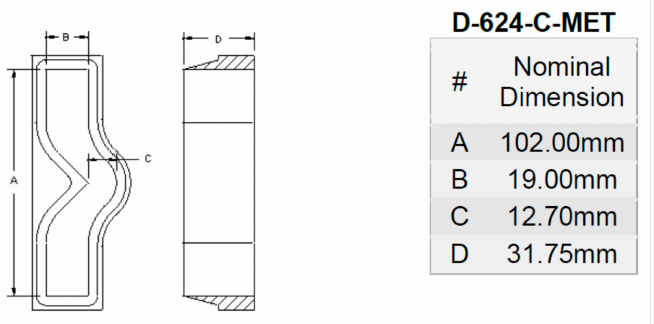
Figure 4. Schematic drawings of tear test specimen according to ASTM D624 Type C [14]. Setup for tensile and tear tests is shown in Figure 5. Both testings were carried out using the same Instron machine.